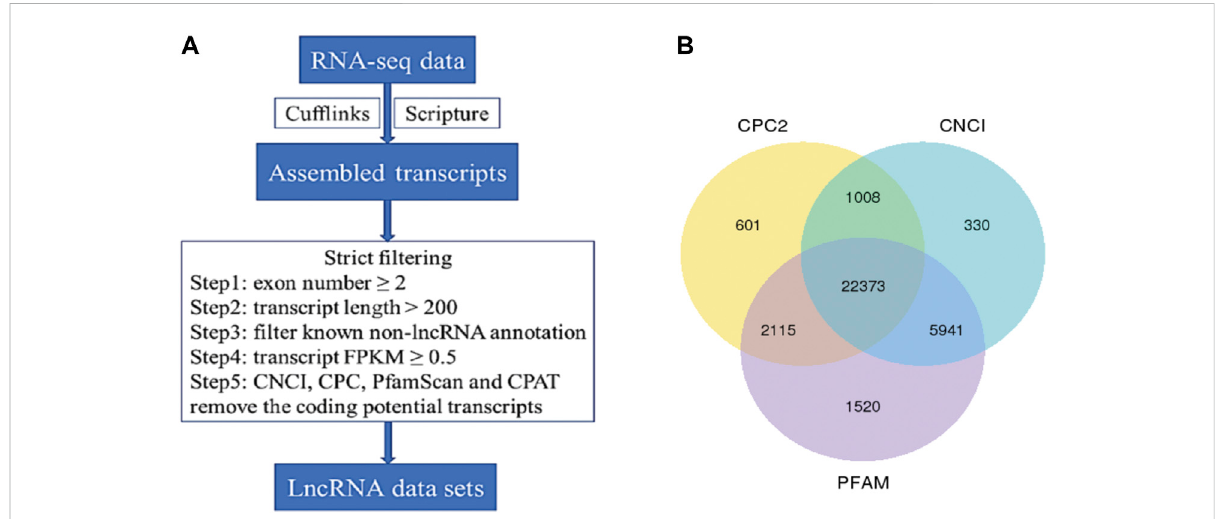
Identi fi cation of long non-coding RNAs (IncRNA) in muscle transcriptome. (A) Work fl ow for IncRNA identi fi cation. (B) Candidate IncRNAs were identi fi ed by using three applications: CNCI, coding-non-coding-index; CPC, coding potential calculator; PFAM-scan which detect and remove putative protein-coding transcripts.